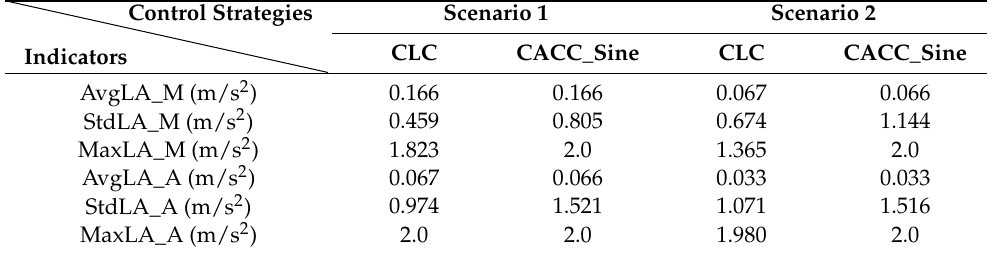
Table 4. Indicator comparison for longitudinal accelerations of two control strategies.